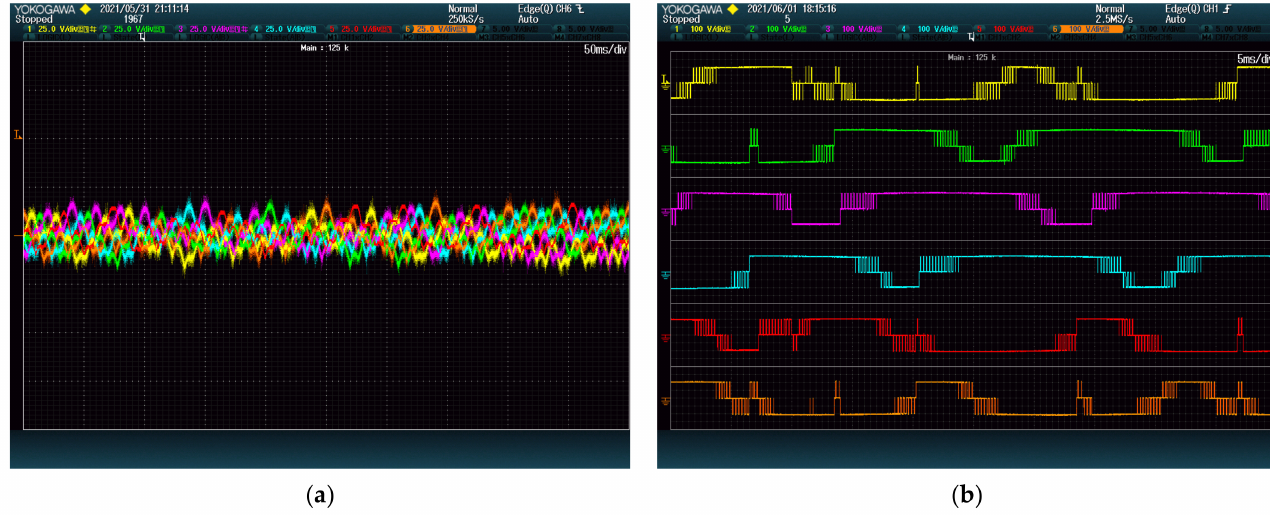
Figure 6. Third test results, with greater gain for switching reduction on all modules ( G Skj = 0.1): ( a ) DC- link voltage ripple (25 V/dv) vs. time (50 ms/div); ( b ) Modules output voltages for 2.5 grid periods. Similar to a level-shifted PWM, only one module commutes in each phase, while the other remains saturated. One module of each phase produces the positive voltage (yellow, red and orange lines), whereas the other produces the negative voltage. In addition, only two modules remain nonsaturated at any given time. This indicates that the algorithm is using common-mode voltage to avoid switching several modules at a time. On the fourth test, G Skj was set back to 0 for one module on each phase (yellow, green and purple lines). For the other modules, G Skj retained its value of 0.1. Thus, switching was penalized only for one module per phase (blue, red and orange lines). The results are shown in Figure